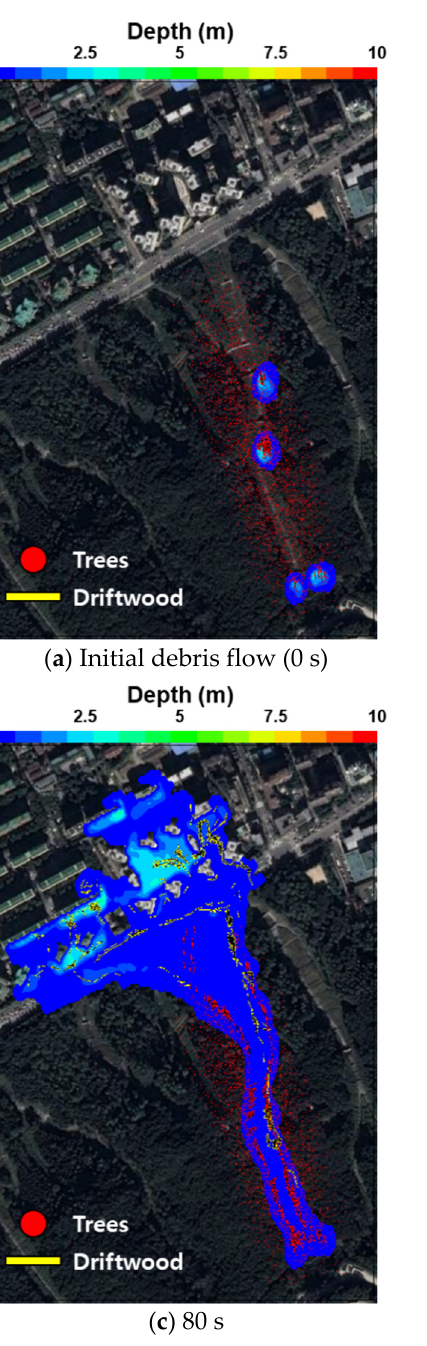
Figure 6. Time changes in simulation result of debris-flow depth (Run4).